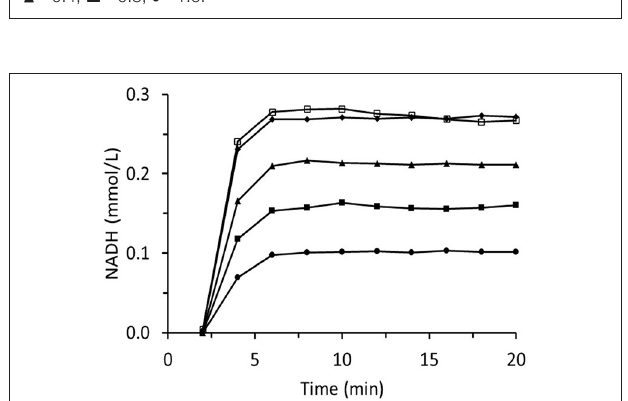
FIGURE 8 | Time dependences of output NADH concentration for the column packed with immobilized ScADH1 and fed with 0.17 mmol/L of NADH solution containing variable inlet trans -2-hexenal concentrations (mg/mL): (cid:7) - 0.2; N - 0.4; (cid:4) - 0.8; • - 1.6.